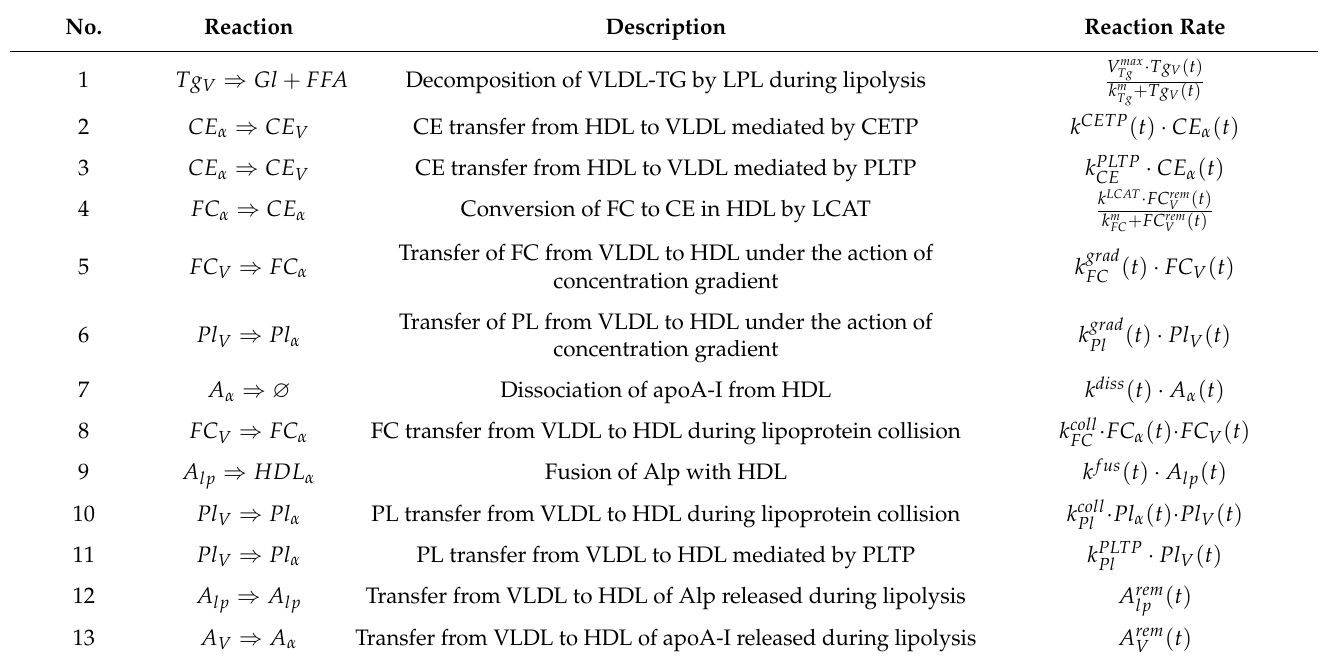
Table 2. Reactions included in the model and their